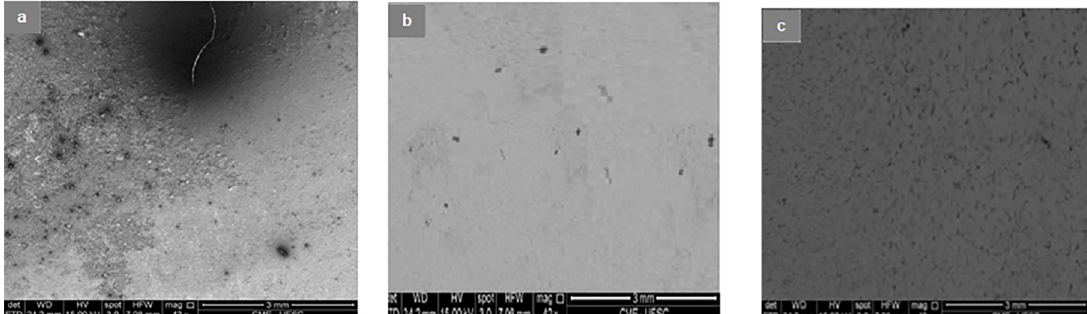
Figure 10. CS - ASTM 1020 surface SEM images after 90 min immersion in 18.23 g L -1 HCl solution in the absence of inhibitor (a) and in the presence of 1.112 g L -1 of BTAH (b) or cocoa bark extract (c).